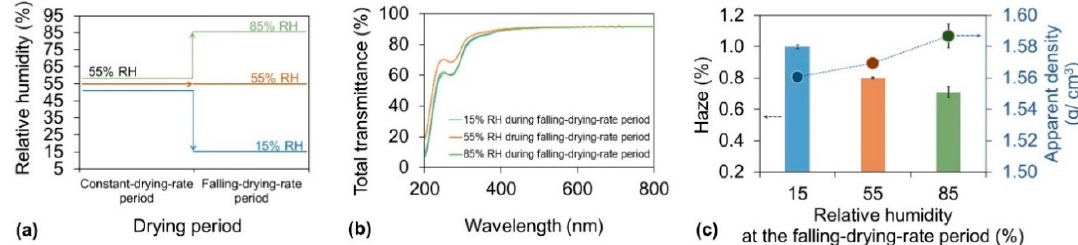
Figure 4. ( a ) Drying strategy for investigation of the relationship between the haze and RH during the falling-drying-rate period. During the drying process, the temperature was 55 °C for the entire period, and the RH was 55% during the constant-drying-rate period and 15%, 55%, or 85% during the falling-drying-rate period; ( b ) Total transmittance of cellulose nanopaper; ( c ) Corresponding haze (bar) and apparent density (dot) of cellulose nanopaper.